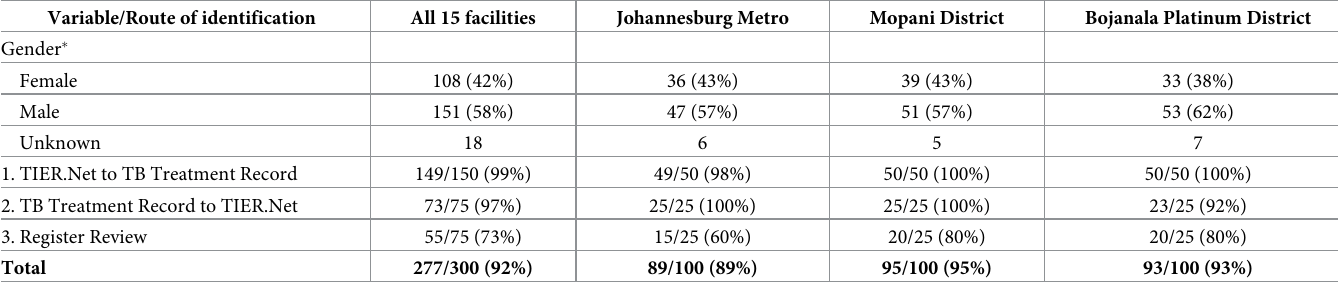
Table 2. Sample description as proportion of